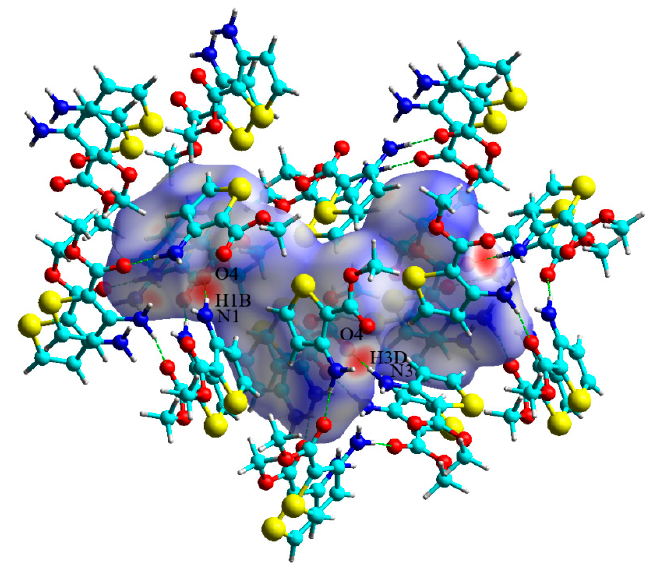
Figure 3. A view of the Hirshfeld surfaces mapped over the d norm of matc. Color scaled from − 0.50 a.u. (red) to 1.20 a.u. (blue).